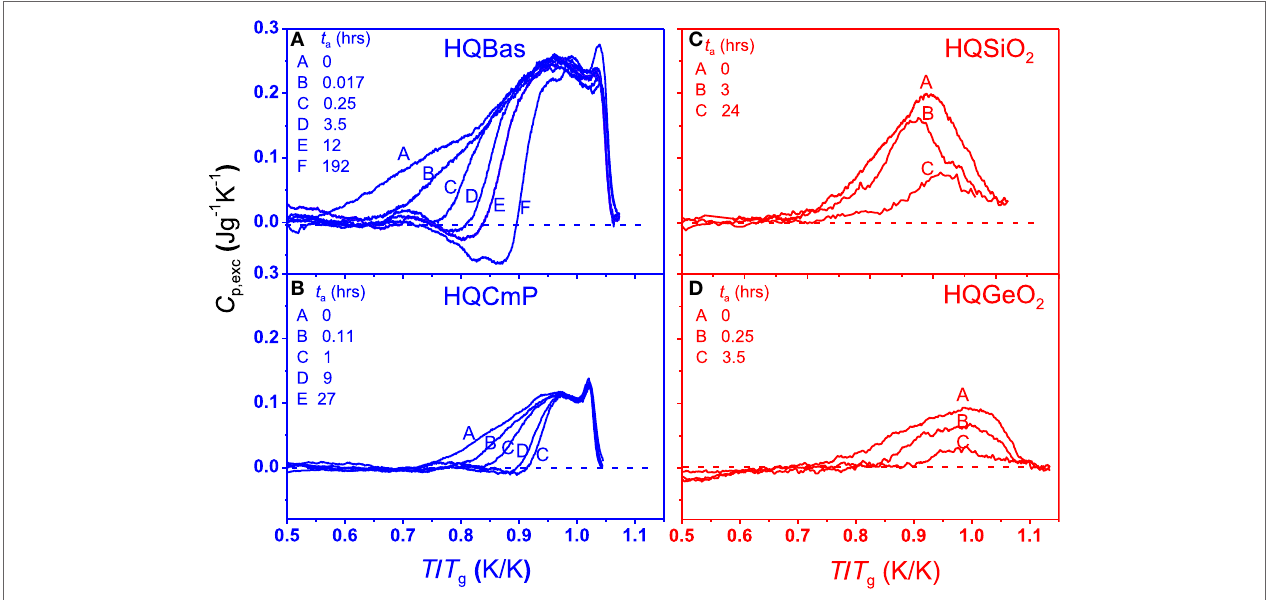
FigUre 6 | effect of annealing time ( t a ) on C p,exc of hQ glasses as a function of T / T g at a given annealing temperatures ( T a ) . The T g values are given in Table 1 . Left panel (fragile systems): (a) HQBas annealed at T a = 723 K (0.77 T g ) (Yue et al., 2002a); (B) HQCmP annealed at T a = 614 K (0.77 T g ) (Yue, 2002). Right panel (strong systems): (c) HQSiO 2 annealed at T a = 973 K (0.75 T g ) (this work); (D) HQGeO 2 annealed at T a = 650 K (0.78 T g ) (Hornbøll and Yue,